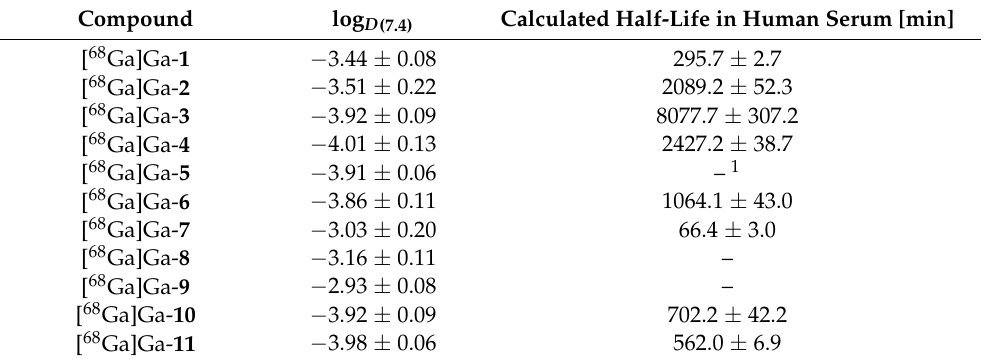
Table 1. Summary of the results of the log D (7 . 4) determination experiments and serum stability tests for [ 68 Ga]Ga- 1 –[ 68 Ga]Ga- 11 . Compound log D (7.4) Calculated Half-Life in Human Serum